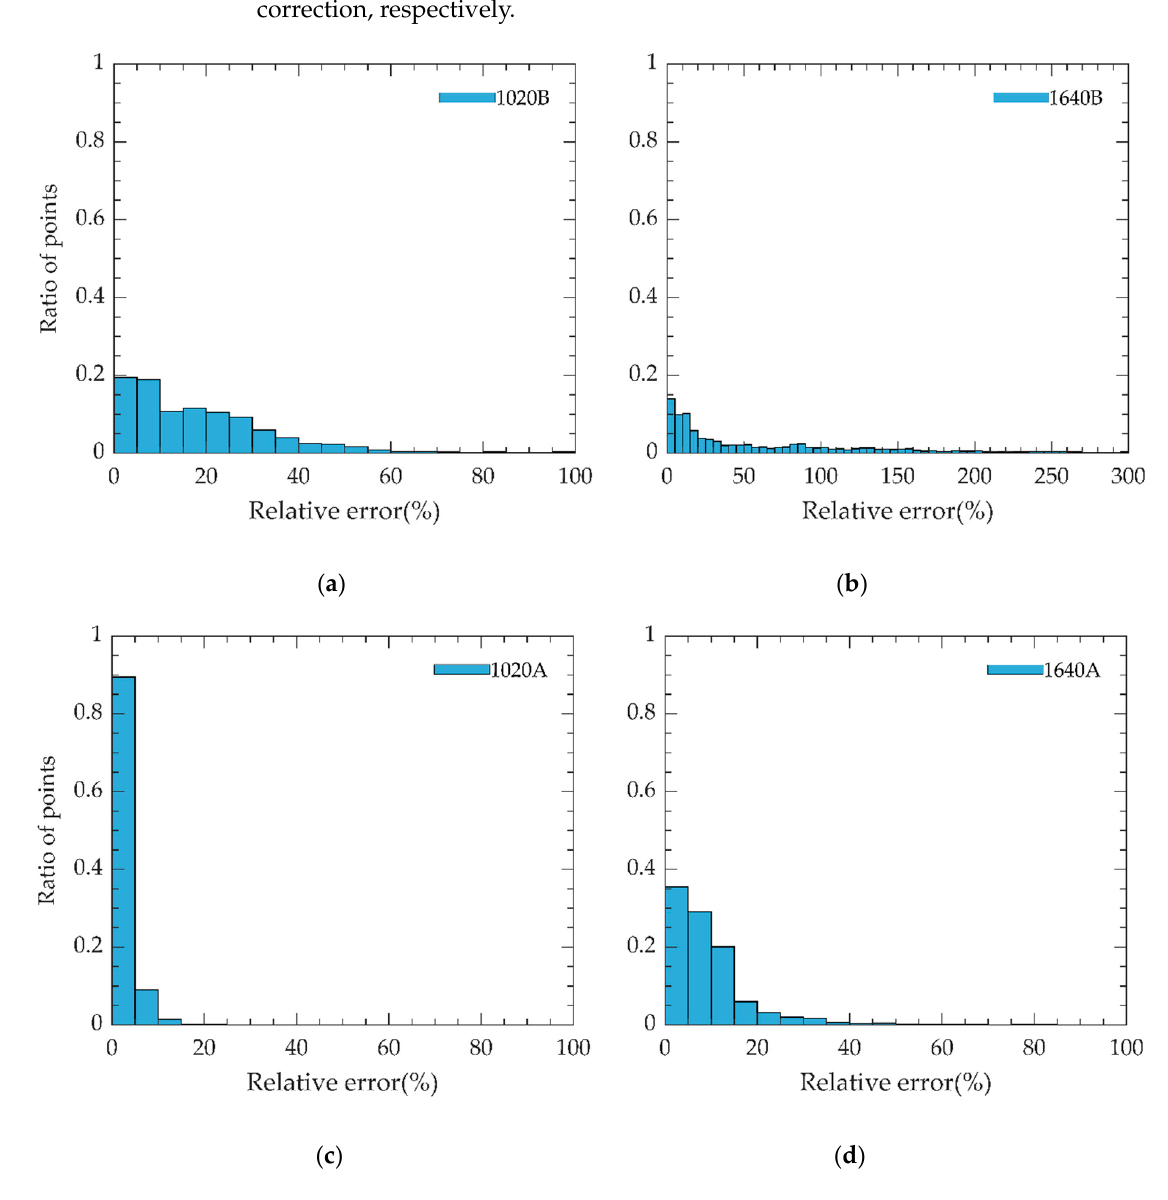
Figure 6. Distribution of RE of the estimated AOD and the theoretical AOD: ( a ) 1020 nm before correction; ( b )1639 nm before correction; ( c )1020 nm after correction; ( d ) 1639 nm after correction.